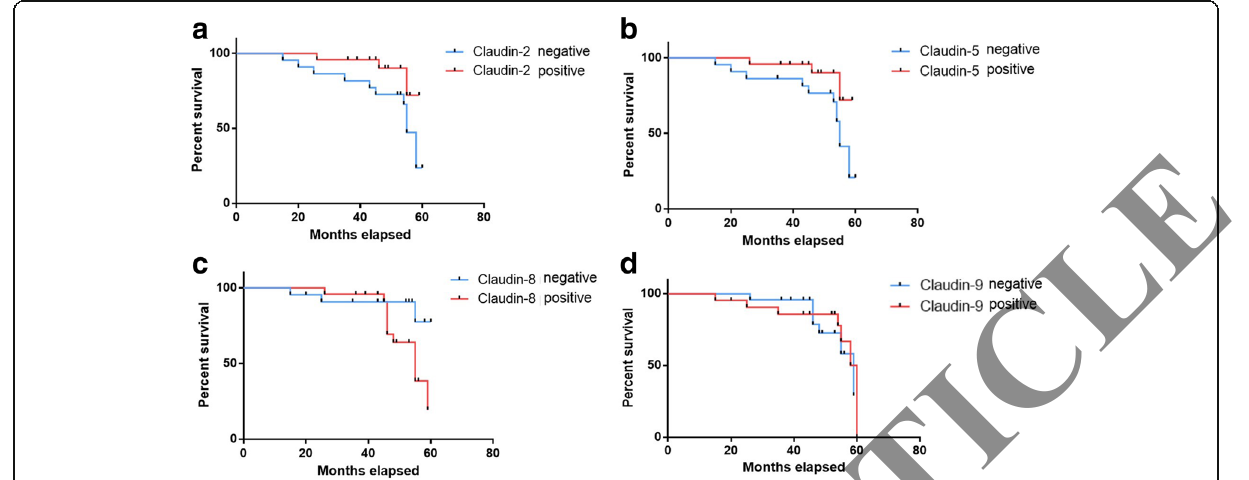
Fig. 4 The correlation between the expression of claudins and survival. Kaplan-Meier analysis were used for survival analysis in nasopharyngeal carcinoma patientsA: Claudin-2 Curve; B: Claudin-5 Curve; C: Claudin-8 Curve; D: Claudin-9